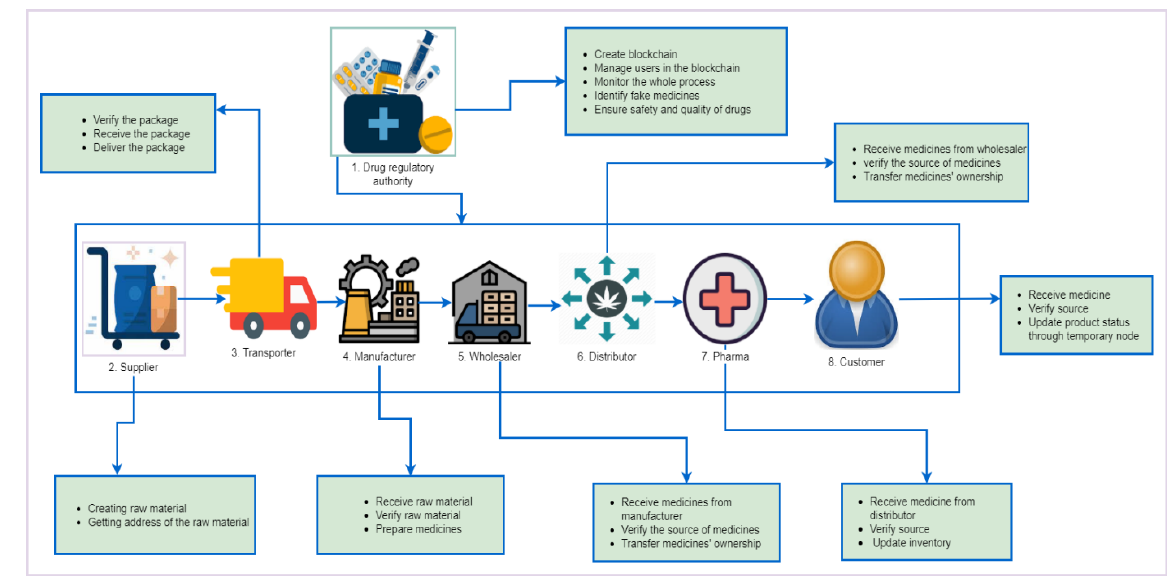
Figure 2. Key responsibilities of the entities involved in the proposed framework.